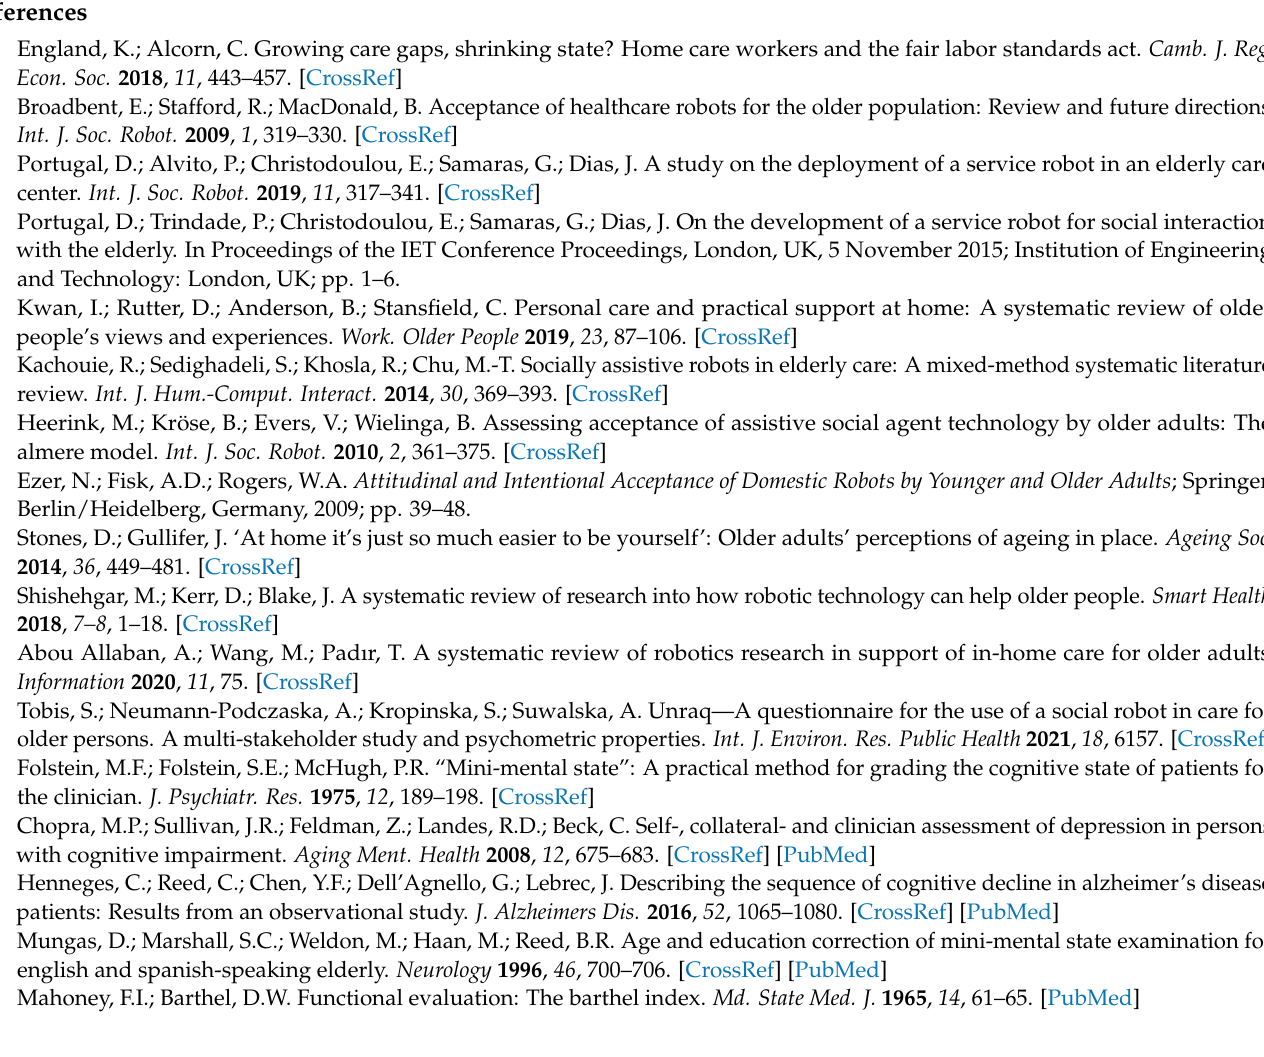
Table S2: Percentages of participants whose opinions worsened after interaction with the robot in relation to the scores of Mini Mental State Examinstion (MMSE) and Barthel